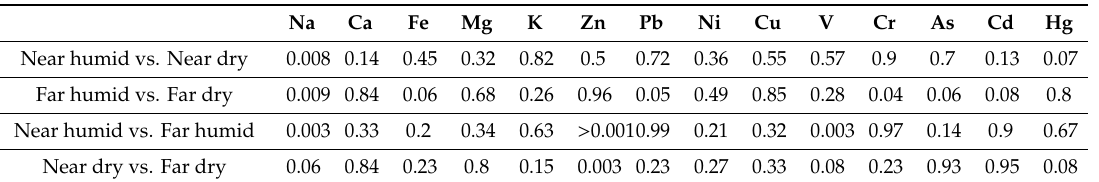
Table 3. Statistical significance between compared sets of values assessed by Mann–Whitney U test. Data reported as p -values (significance level alfa at